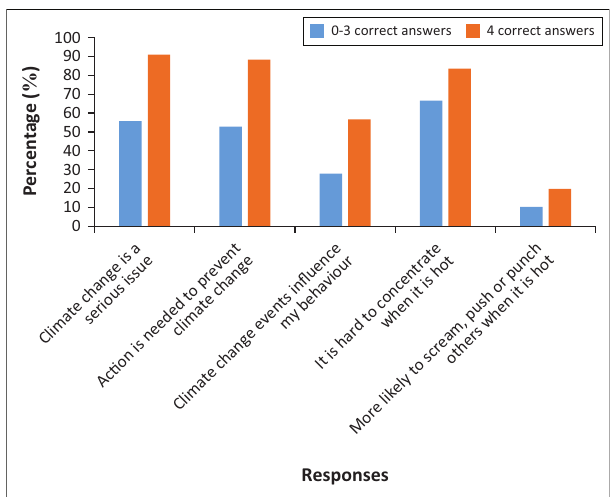
FIGURE 1: Comparison of knowledge levels and climate-related experiences between pupils with high and low levels of knowledge about climate change.